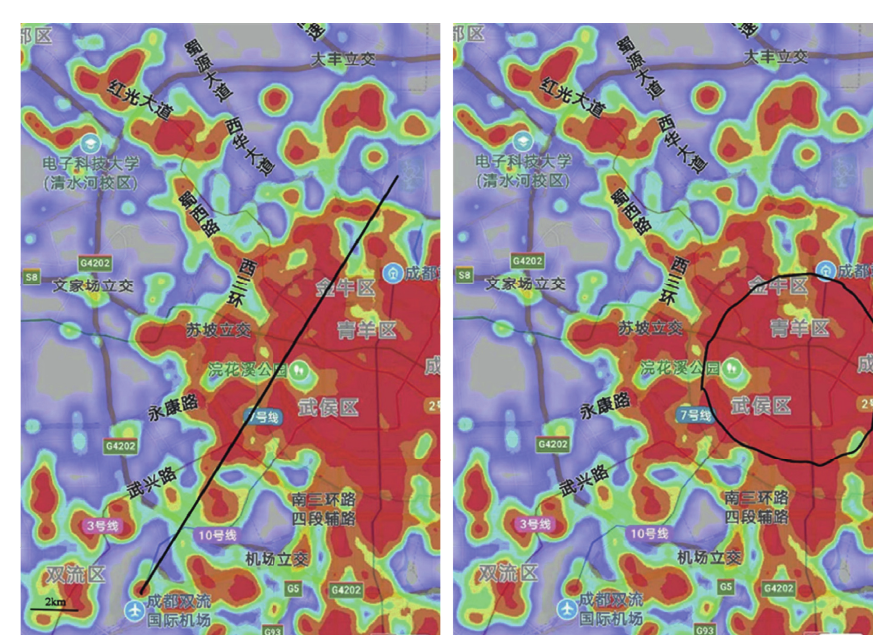
Figure 5: Heat map of population distribution in Chengdu.